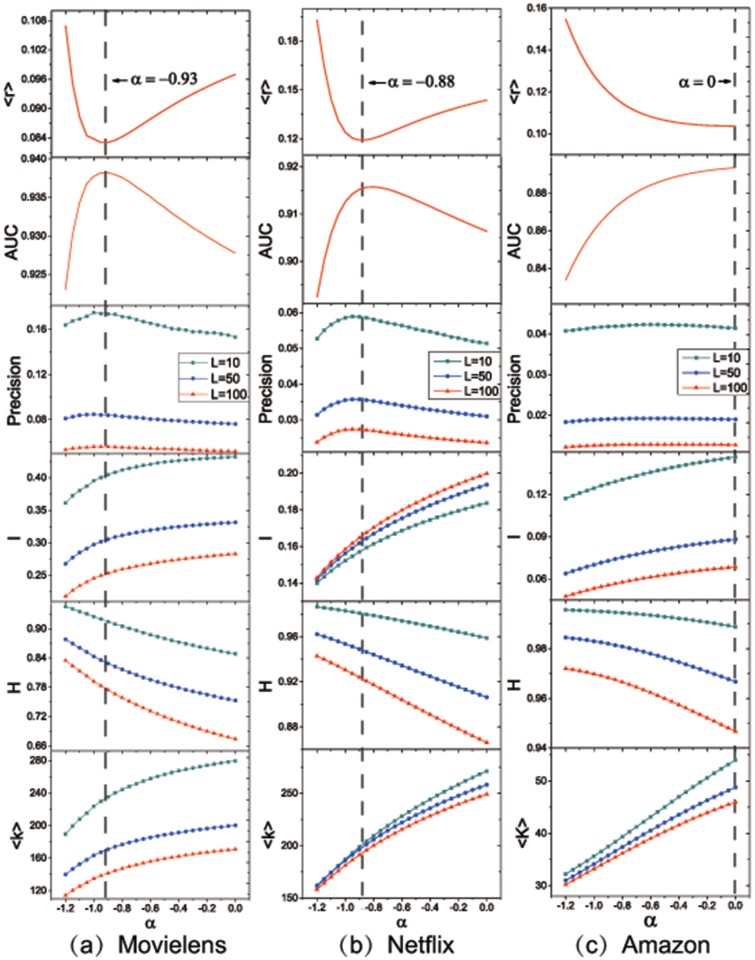
Demonstration of performances of CRE under optimal parameter (α = -0.93 in Movielens, -0.88 in Netflix and 0 in Amazon, from the left to the right) of lowest ranking score, with L = 10, 50 and 100.From the top to the bottom, the subgraphs exhibit ranking score, AUC, precision, intra-similarity, hamming distance and average degree in the parameter range [-1.2, 0], to confirm the performance promotion under depressing similarity redundancy, regardless of the recommendation list’s length L.